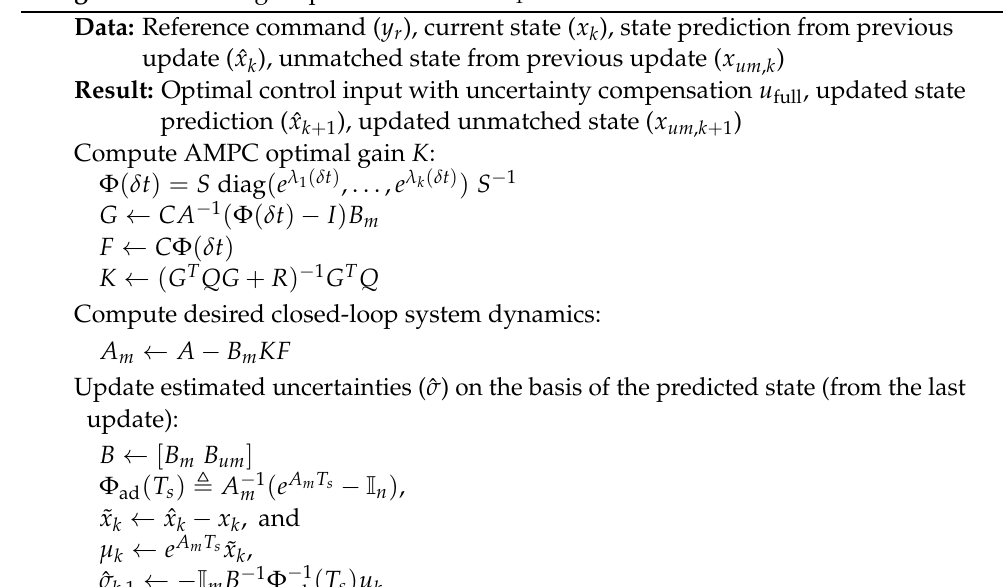
Figure 1. AMPC- L 1 control structure for systems with uncertainties ˆ σ 1 ( t ) , ˆ σ 2 ( t ) . Algorithm 1: A single update of AMPC - L 1 for the k -th